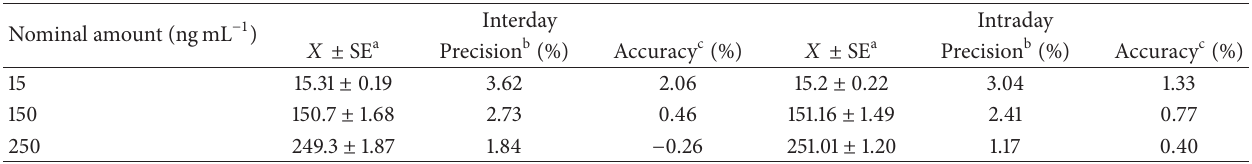
Figure 2: Yield of the derivatization reaction using MSTFA/NH4I/ 𝛽 -mercaptoethanol (a) and MSTFA (b) under different temperature and time periods. Table 3: Intra- and interday precision and accuracy results for VIL ( 𝑛 = 6